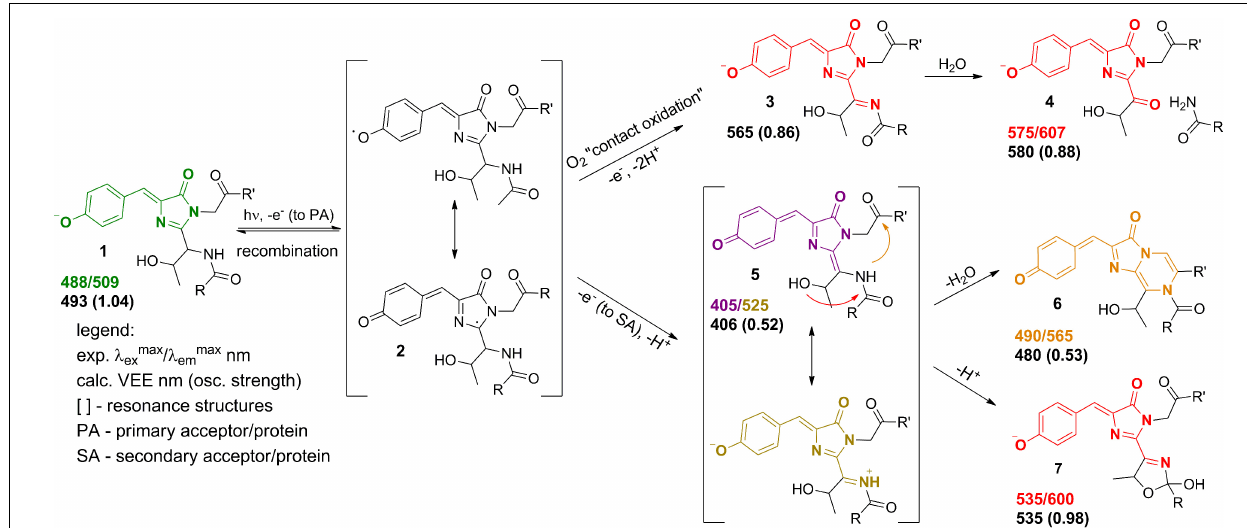
FIGURE 9 | Proposed mechanism of the green-to-red GFP photoconversions. The molecular species correspond to (1) – the native GFP chromophore, (2) – the radical state, (3,4) – the red-emitting forms in oxidative redding, (5) – the green-emitting quinoid-like form detected upon photoconversion under the low-oxygen conditions, (6,7) – the orange and red-emitting photoproducts observed under the low-oxygen